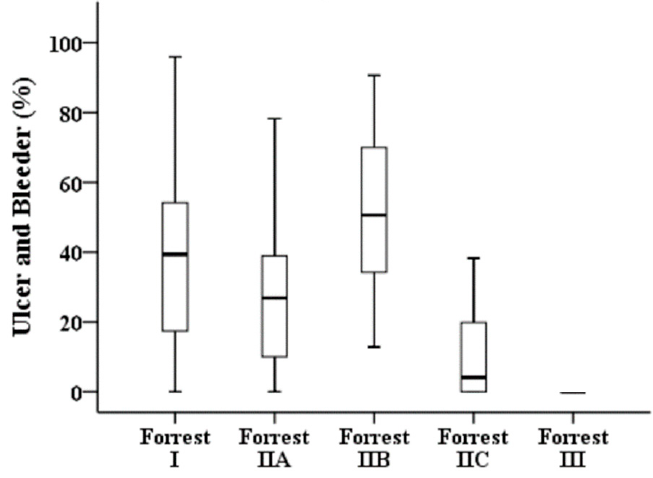
Figure 4. Proportions of overlapping areas of ulcers and bleeders in the different stages of the Forrest classification.